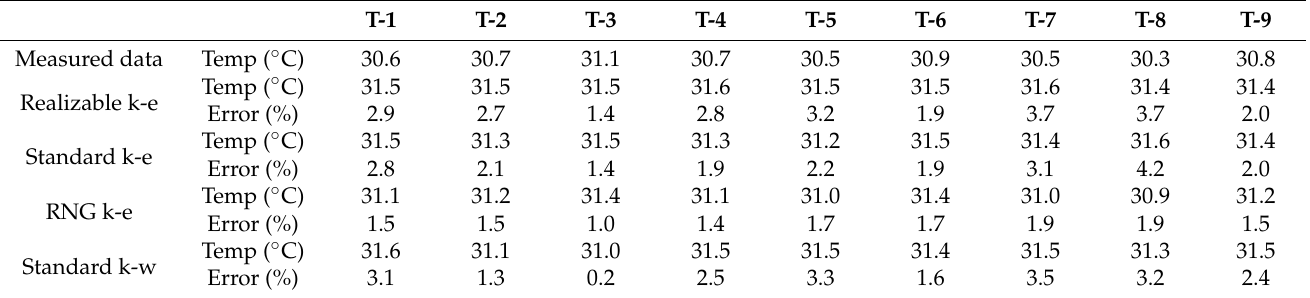
Table 6. Measured and CFD computed air temperature and error according to the turbulence models.